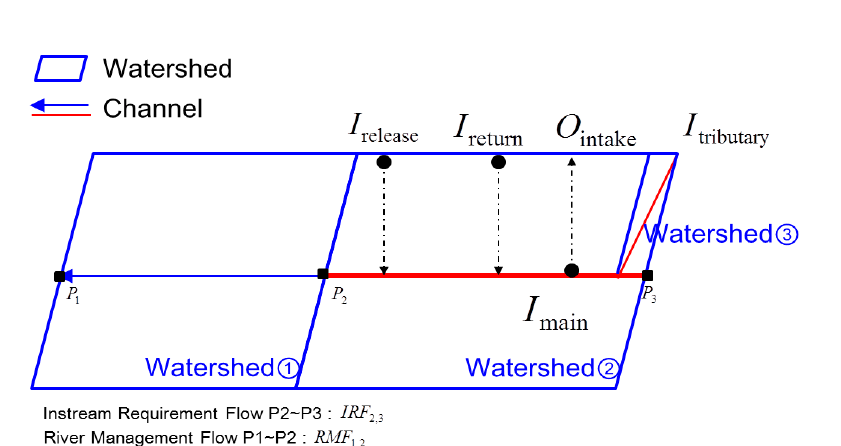
Figure 7. Schematic showing calculation of the RMF for the main stream.